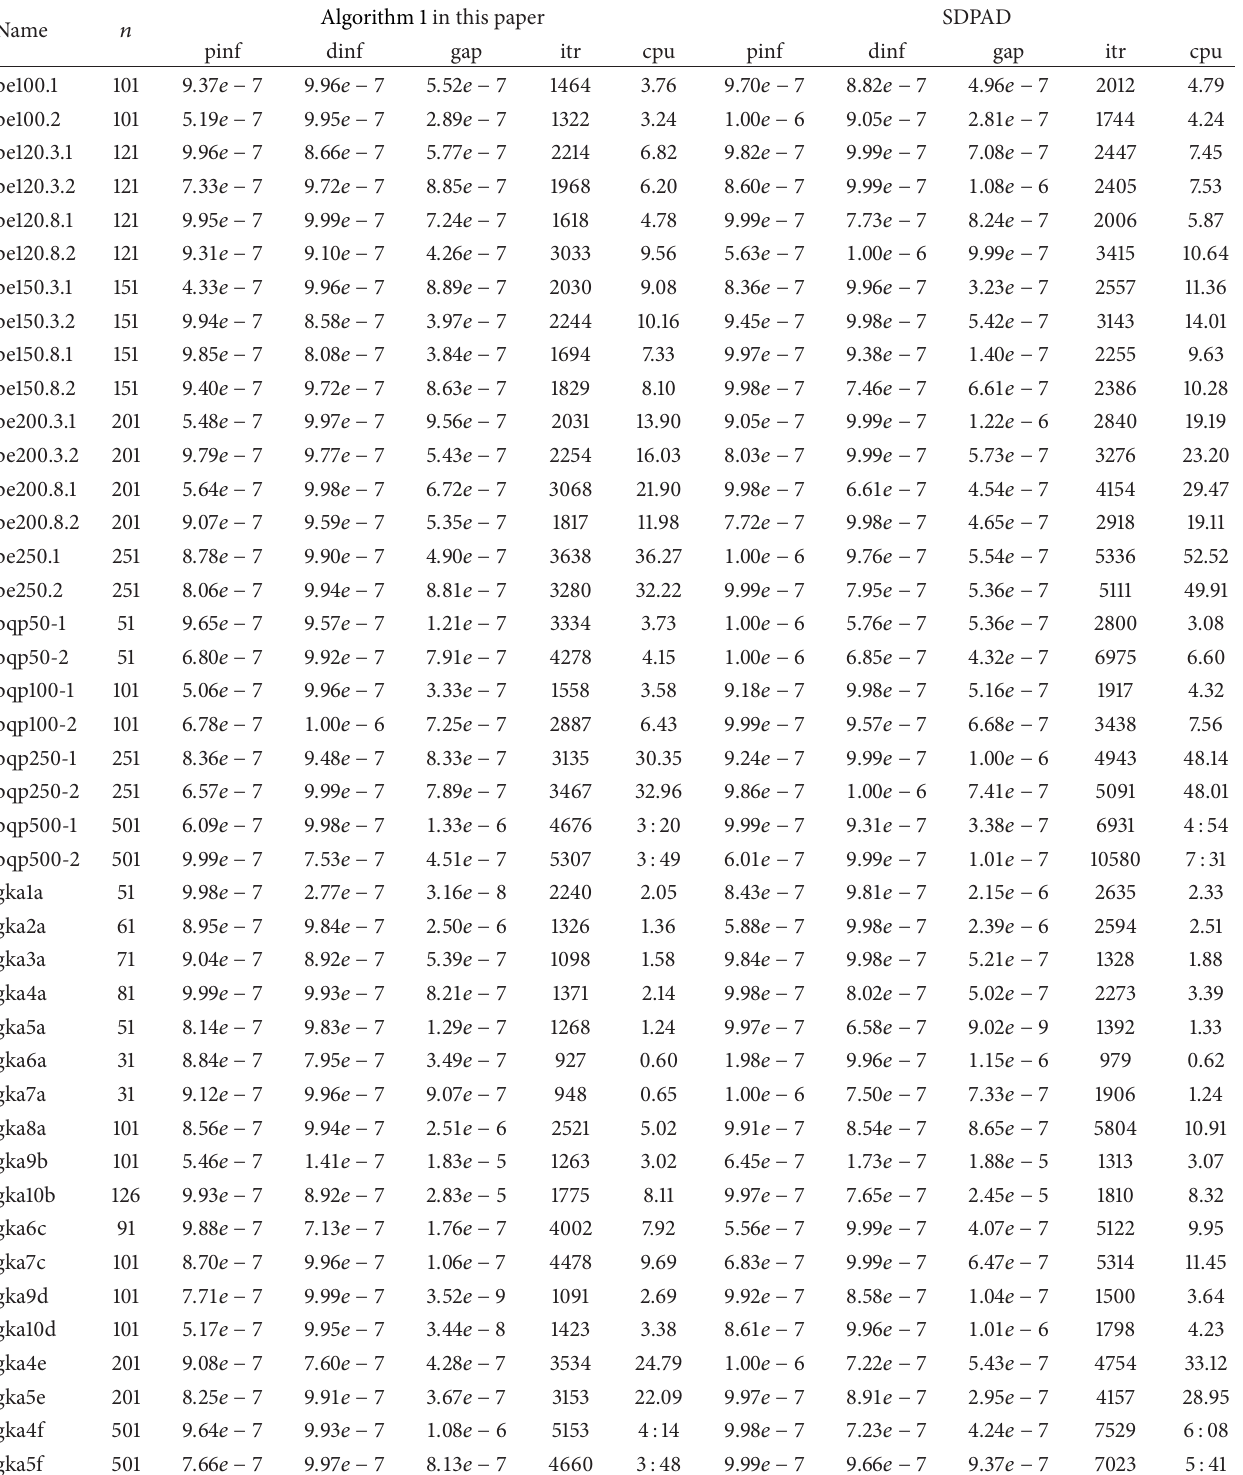
Table 2: Numerical results compared with [16] for computing binary integer quadratic programs